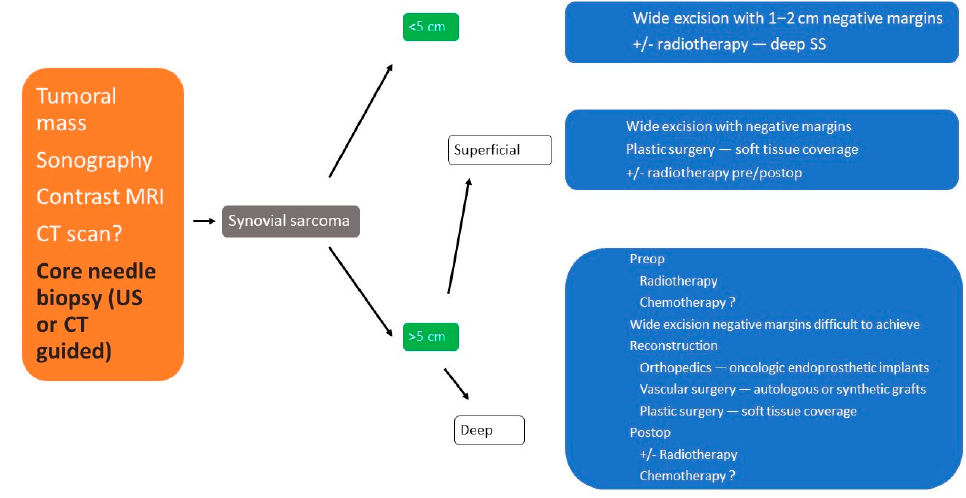
Figure 10. Therapeutic algorithm in synovial sarcoma of extremities.